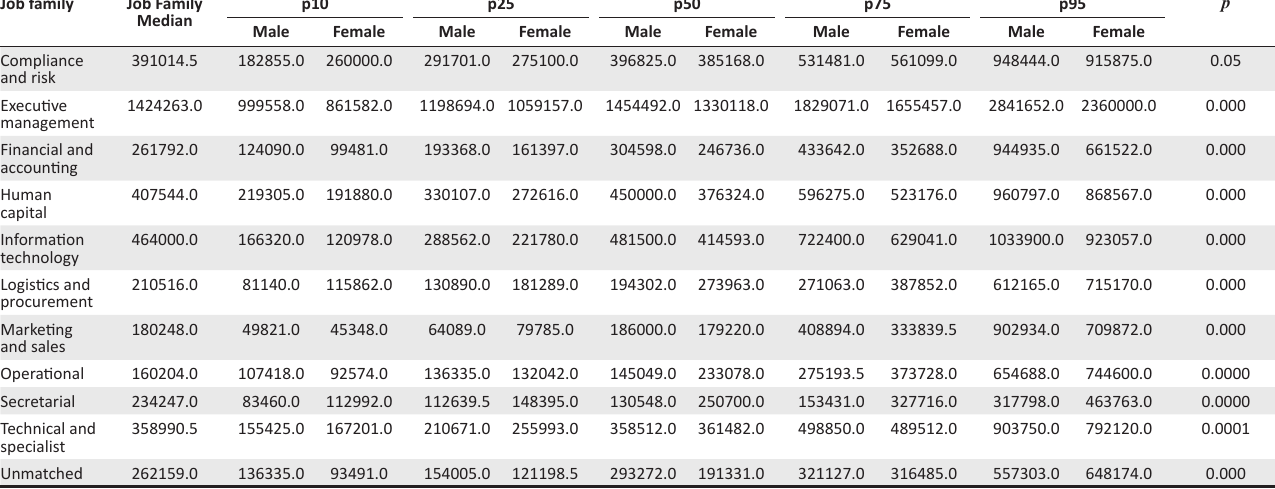
TABLE 3: Income distribution trends.